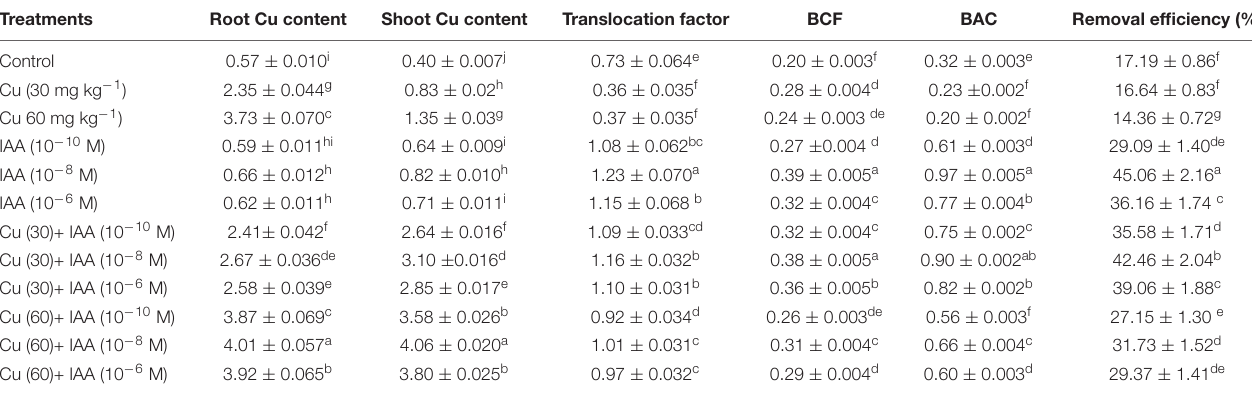
TABLE 8 | Effect of different levels of soil applied Cu (0, 30, or 60 mg kg − 1 ) and/or MEL (30, 60, and 90 µ M) on copper content (root and shoot) ( µ g g − 1 DM), translocation factor (%), BCF (bio-concentration factor), BAC (bioaccumulation coefficient), and removal efficiency (%) of Brassica juncea at 45 DAS. Treatments Root Cu